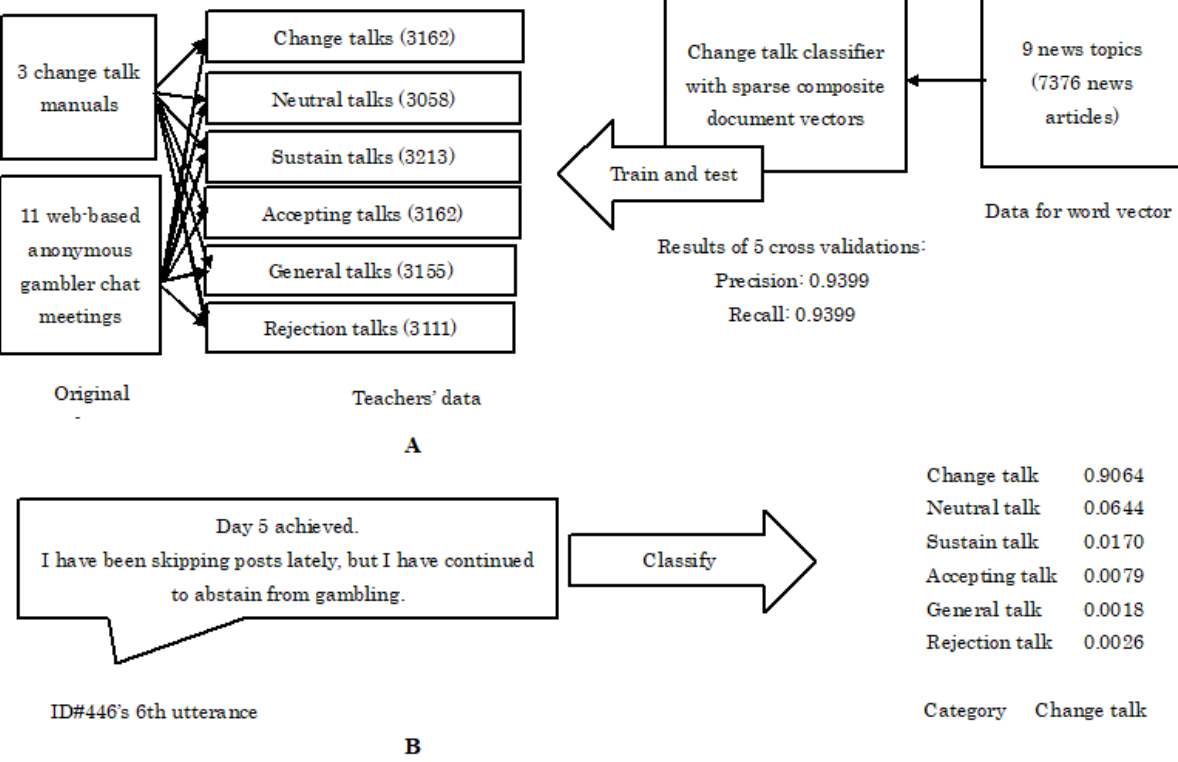
Figure 3. Implementation of an automatic change talk classifier. A: Data sets for the change talk classifier; B: An example of a change talk